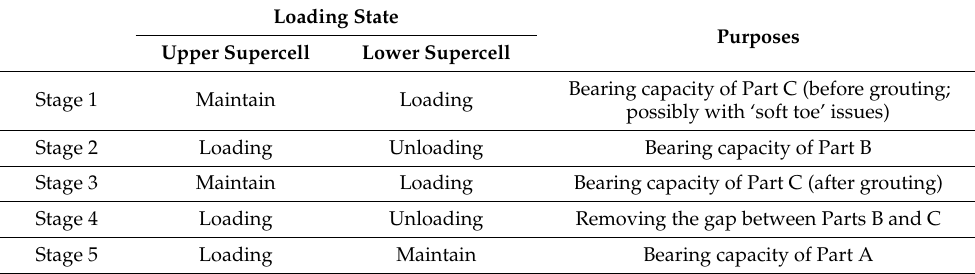
Table 4. Procedure and purposes of the BDSLTs.